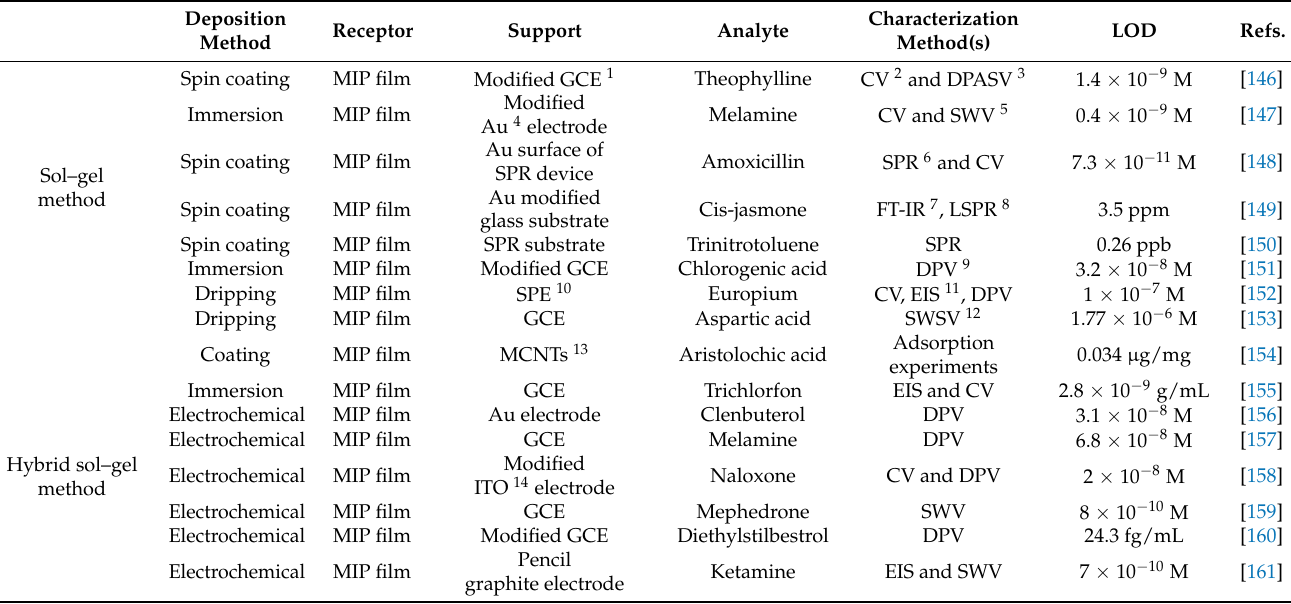
Table 4. MIP-based sensors obtained by sol–gel